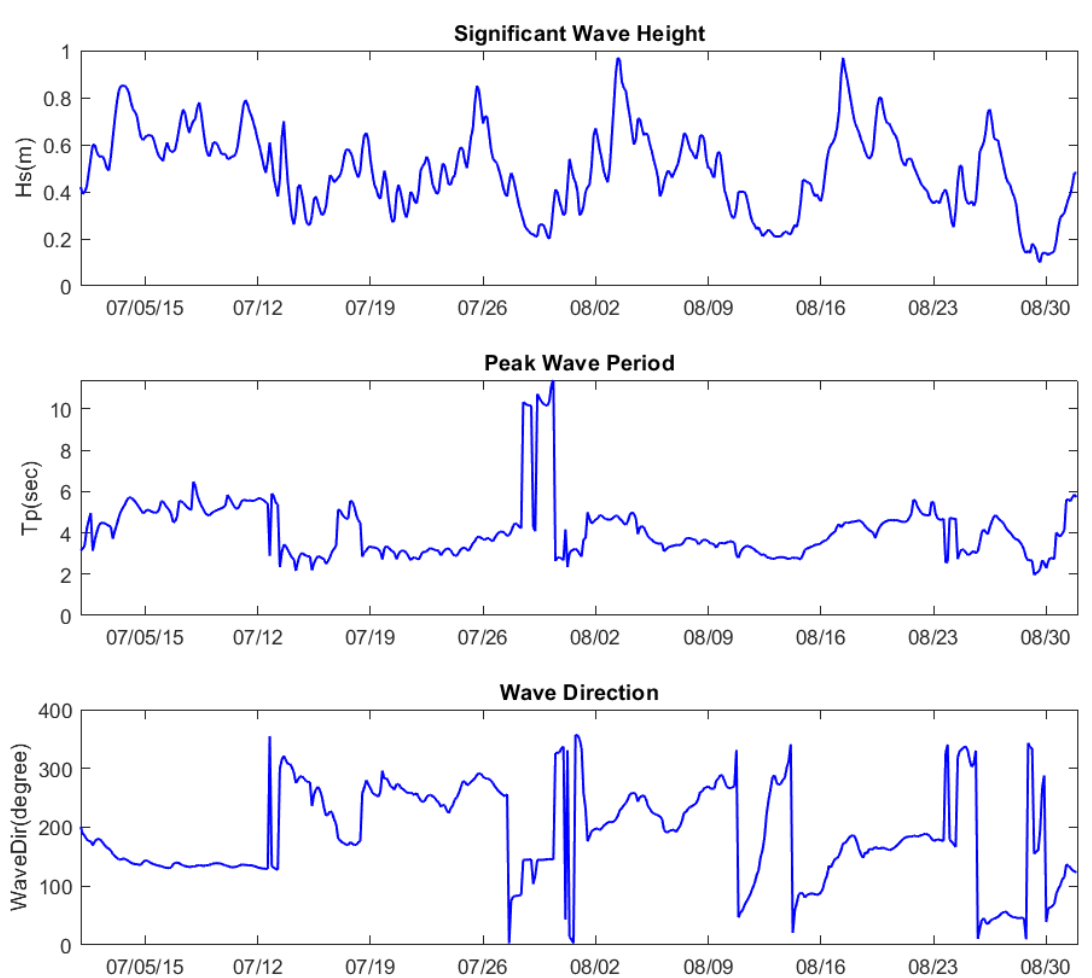
Figure 4. Timeseries of wave parameters: significant wave height ( top panel ), peak period ( middle panel ), and wave direction ( bottom panel ) from the WWIII hindcast in the middle of model southern boundary during July–August 2015.